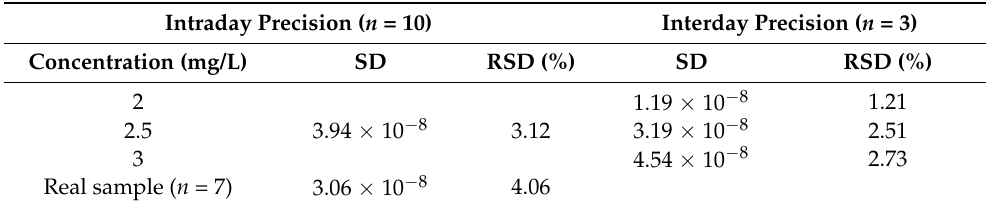
Table 5. Intra- and interday precision for tryptophan (SD: standard deviation; RSD: relative standard